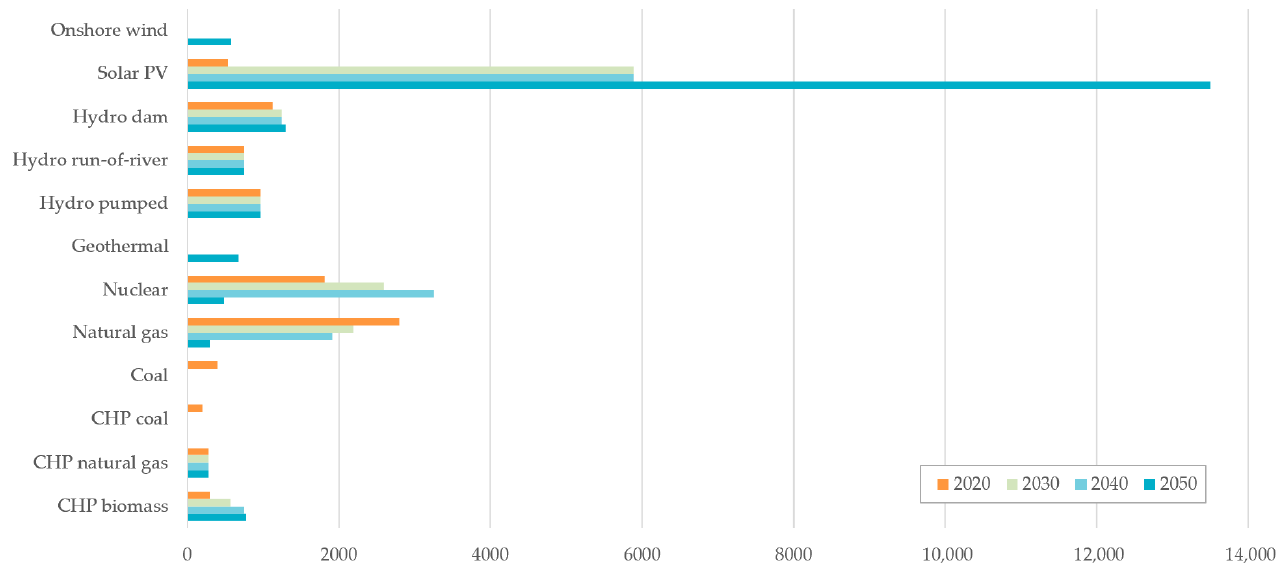
Figure 4. Installed capacities of the electricity generation by technology production under the low-carbon scenario in 2020, 2030, 2040, and 2050 in MW e .